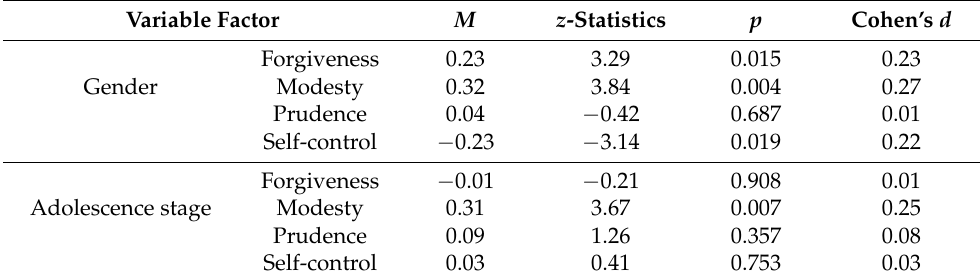
Table 5. Latent means differences by gender and adolescence stage.